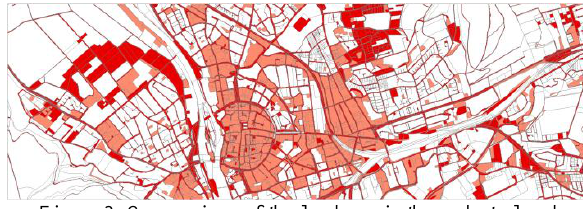
Figure 3: Comparison of the land-use in the cadastral and topographic dataset: Objects of different land-use domains are displayed in dark red, with same domain in light red and with identical classes in white.